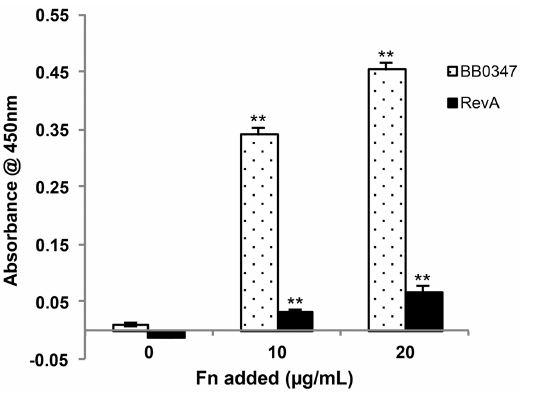
Figure 2. Recombinant BB0347 binds Fn in a dose-dependent manner. Fn-binding was determined by ELISA using BSA (negative control), RevA (positive control), and BB0347 as coating proteins. Fn was added to wells (0, 10, and 20 m g/mL) allowed to bind, and any unbound